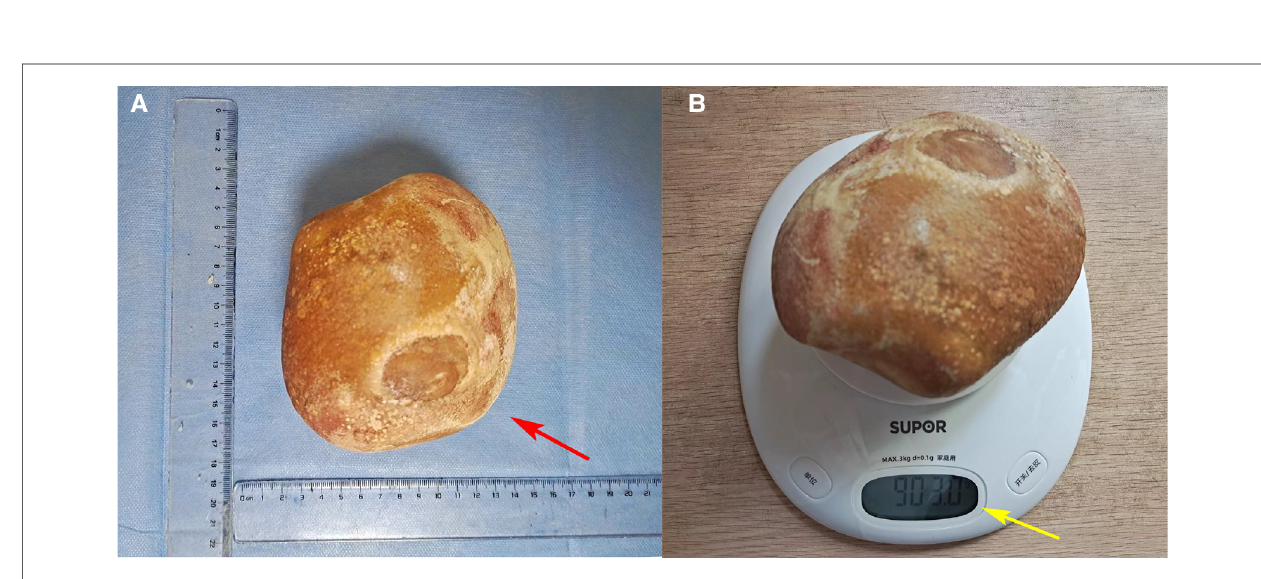
FIGURE 2 The size ( A , red arrow) and weight ( B , yellow arrow) of neobladder